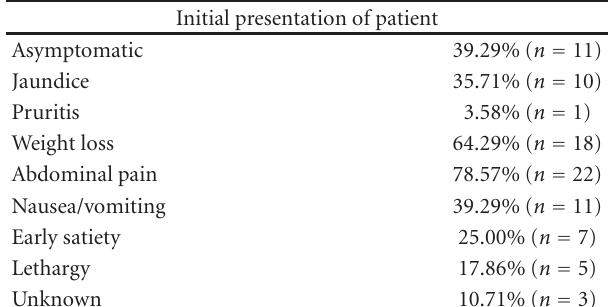
Table 1: Patient presenting